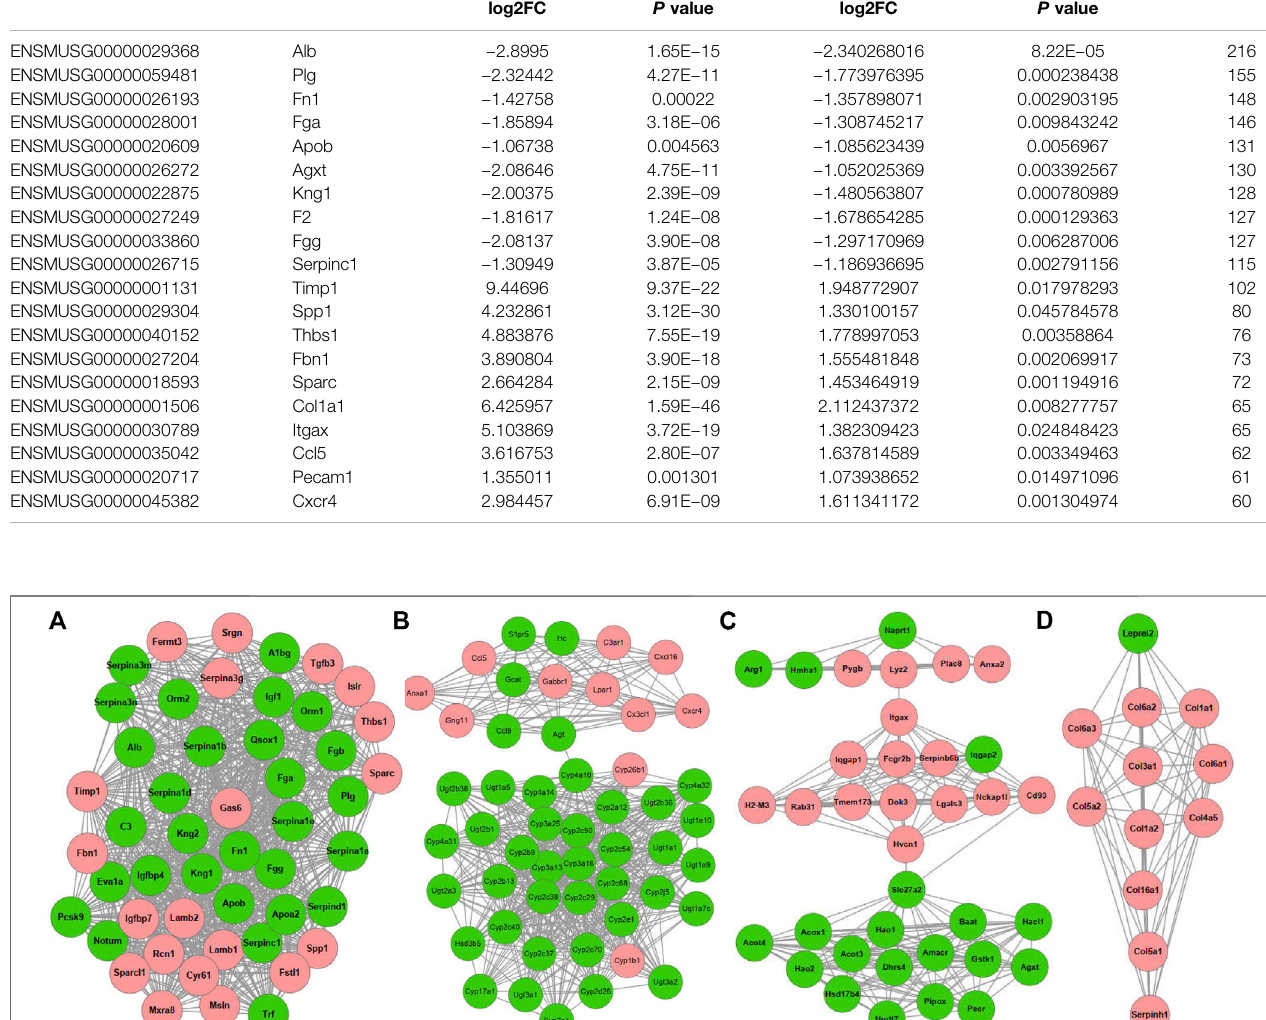
Frontiers in Pharmacology |